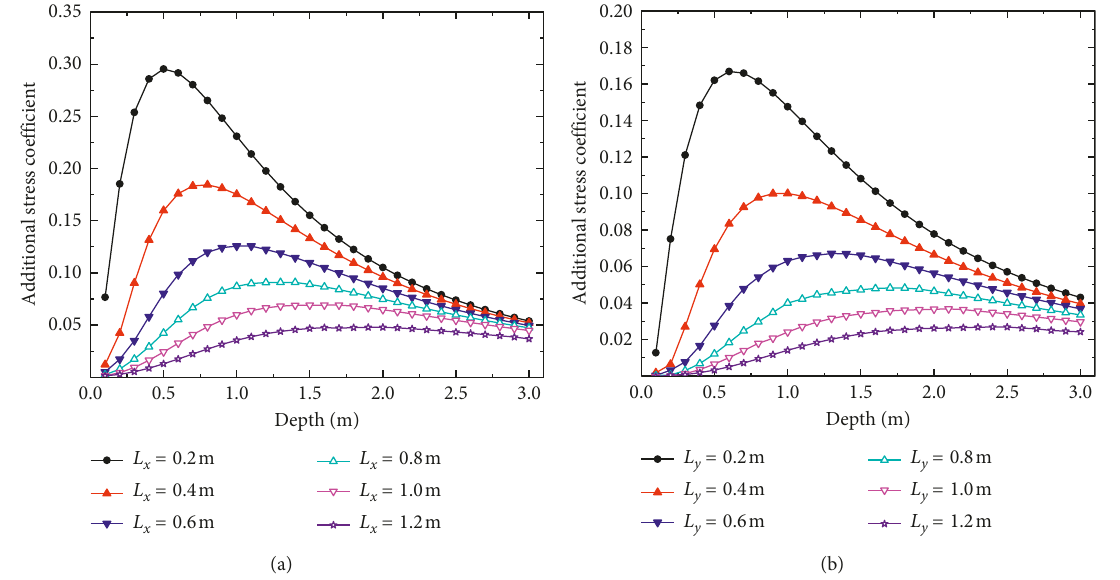
Figure 17: Additional stress coefficients in the external regions: (a) region A; (b) region B.